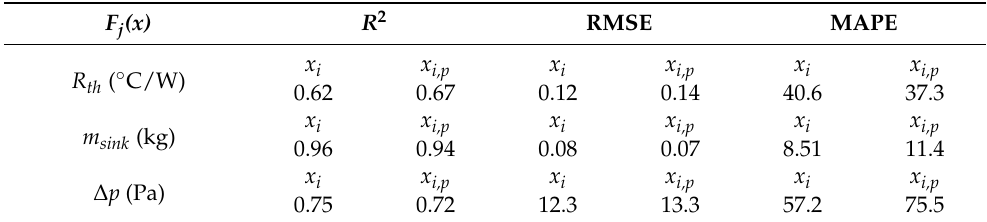
Table 2. Statistical regression parameters for the various objective functions referred to both design variables and Pareto front design variables.